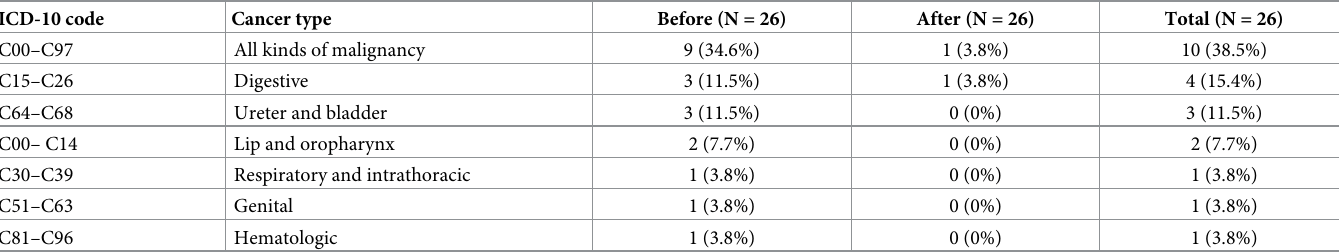
Table 2. Associated malignancy in patients with BHD syndrome before and after folliculin gene test.